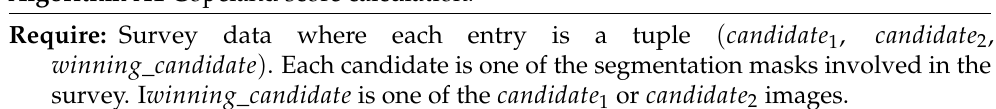
Algorithm A1 Copeland score